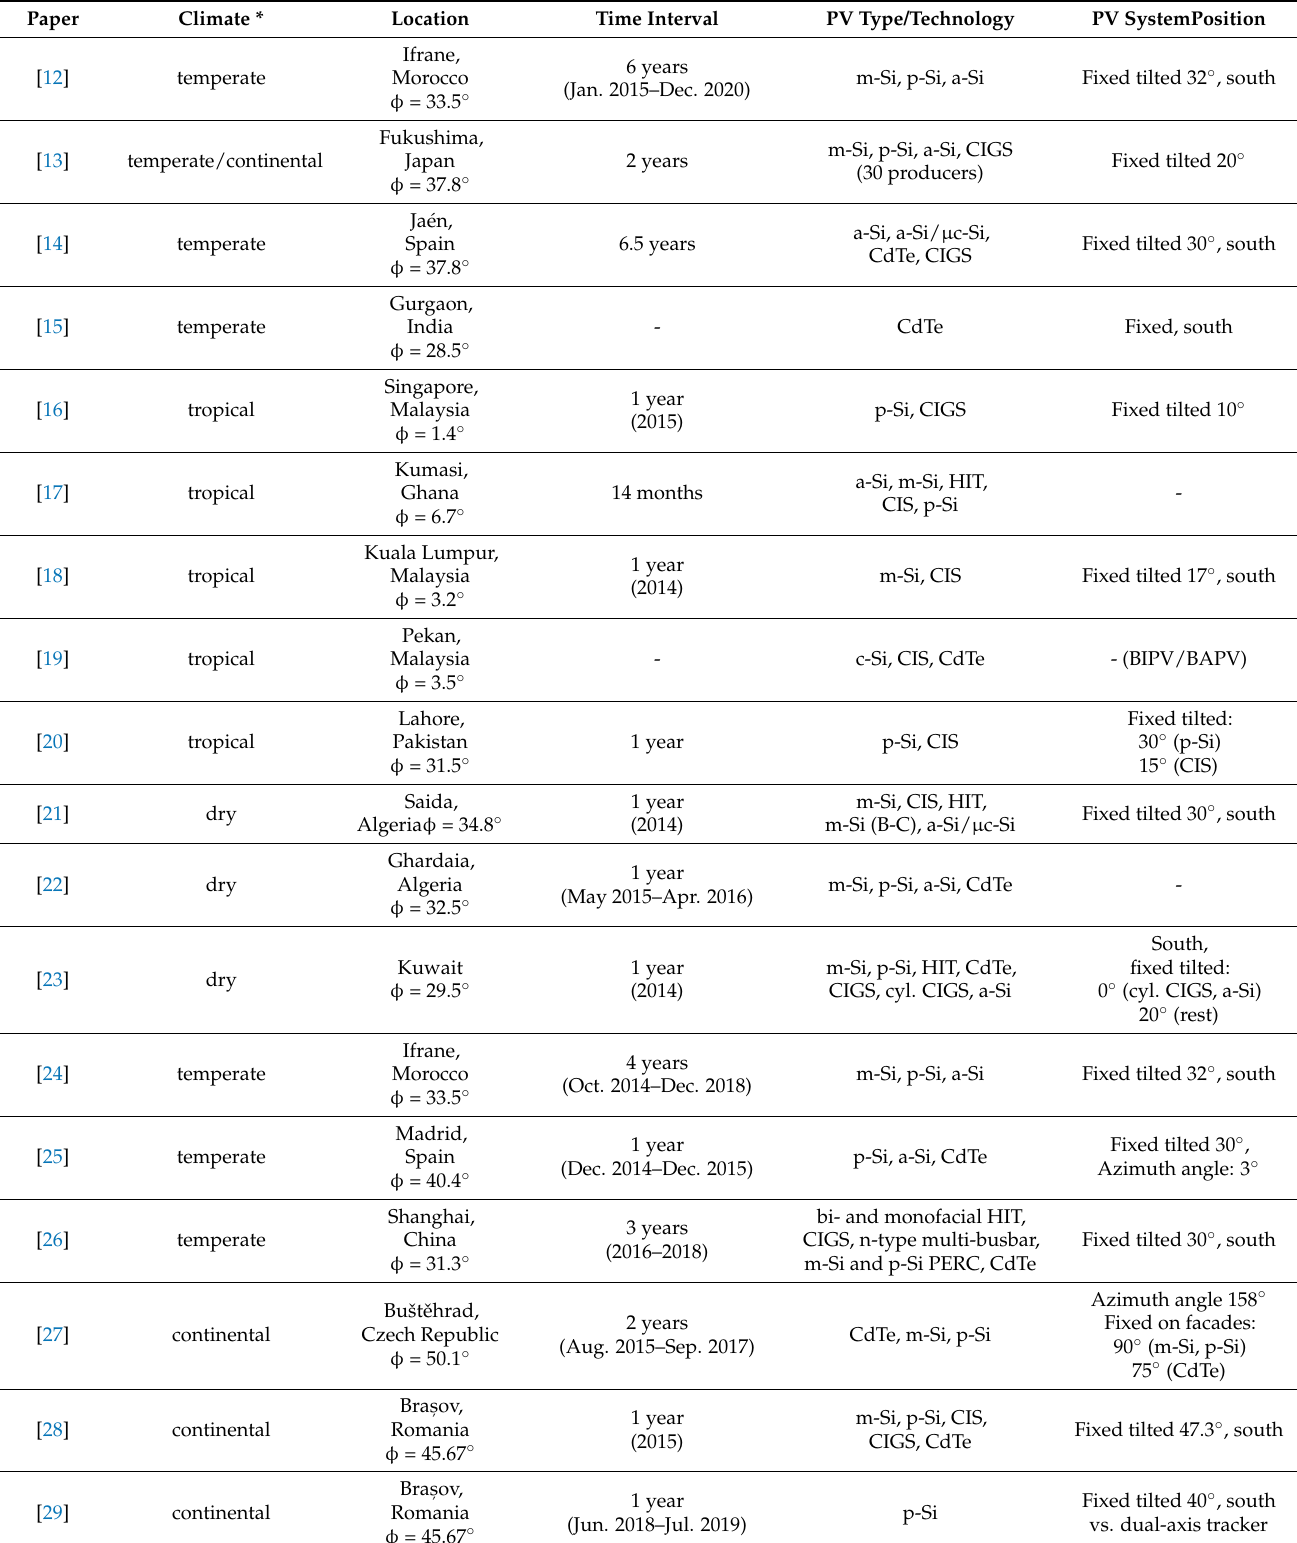
Table 1. Main parameters of the studied literature.